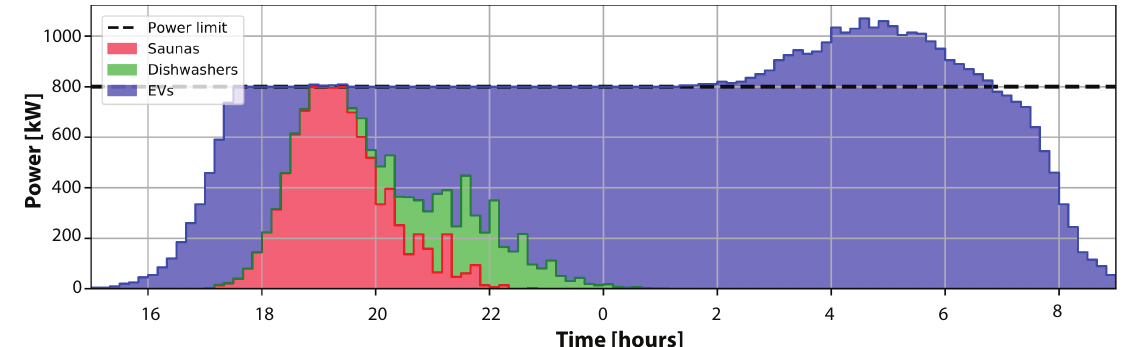
Figure 5. Results for the coordinated demand response for 1000 houses considering the aggregate power consumed from 3 p.m. to 9 a.m. in the following